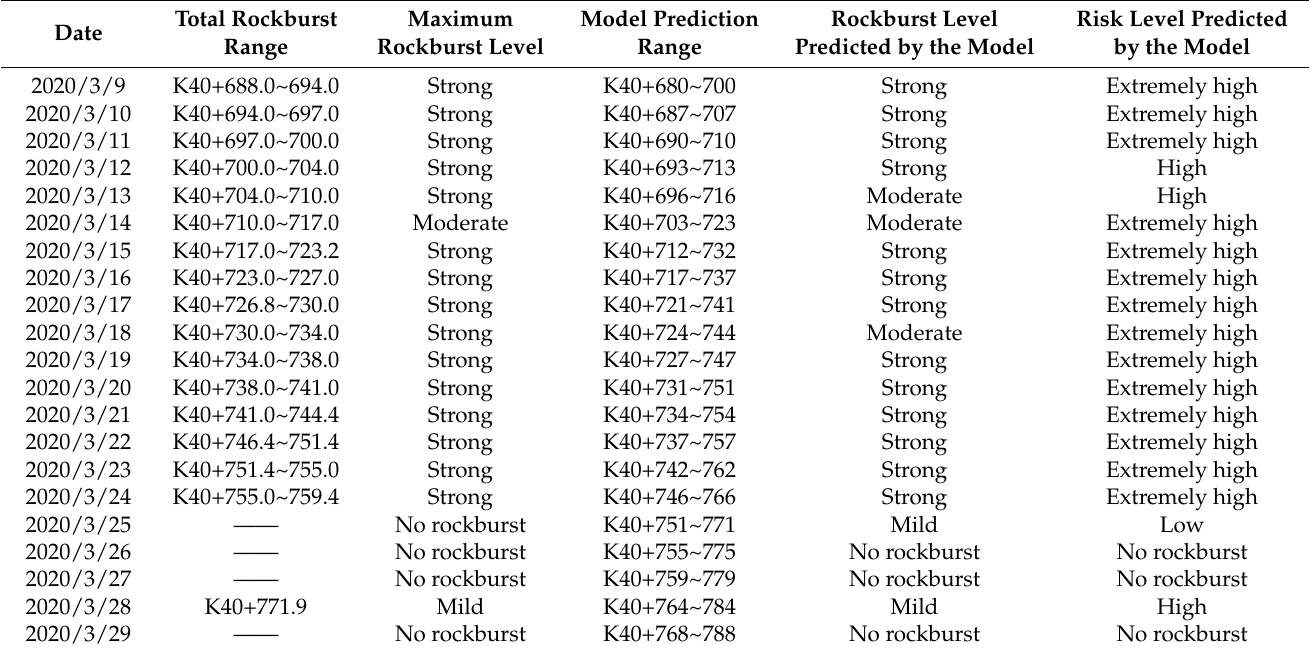
Table 2. Comparison of the real performance of the model applied to the early warning of rockbursts (a